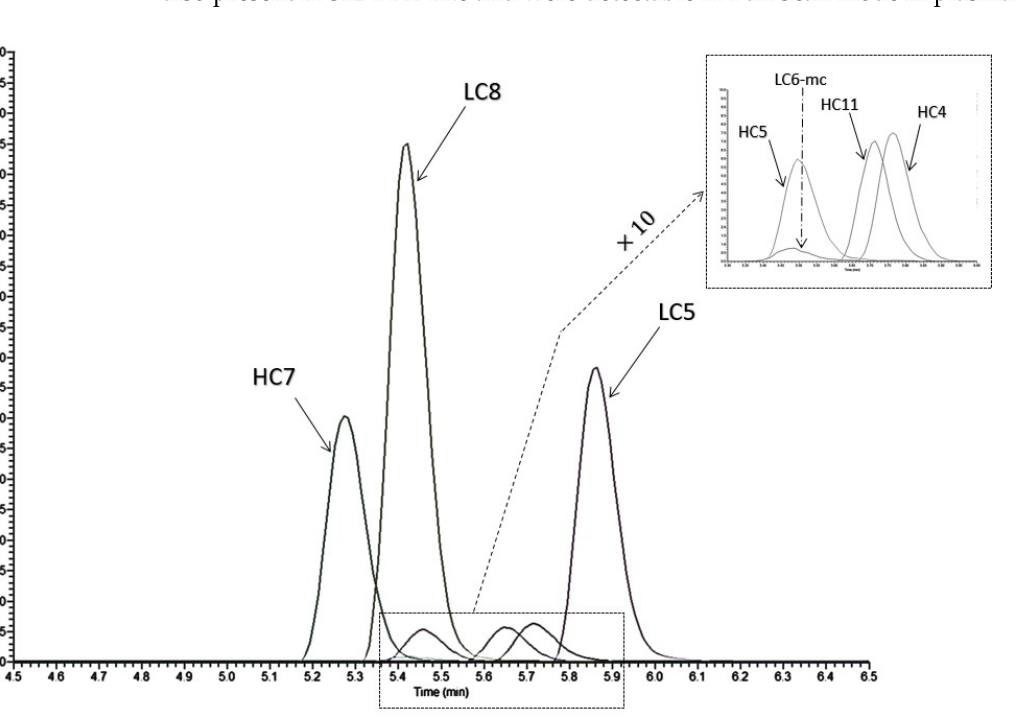
Figure 3. Chromatogram of proteotypic peptides obtained in Full Scan mode analysis. Sample was from a pure solution of pembrolizumab (20 μg/mL) after proteolysis by trypsin.